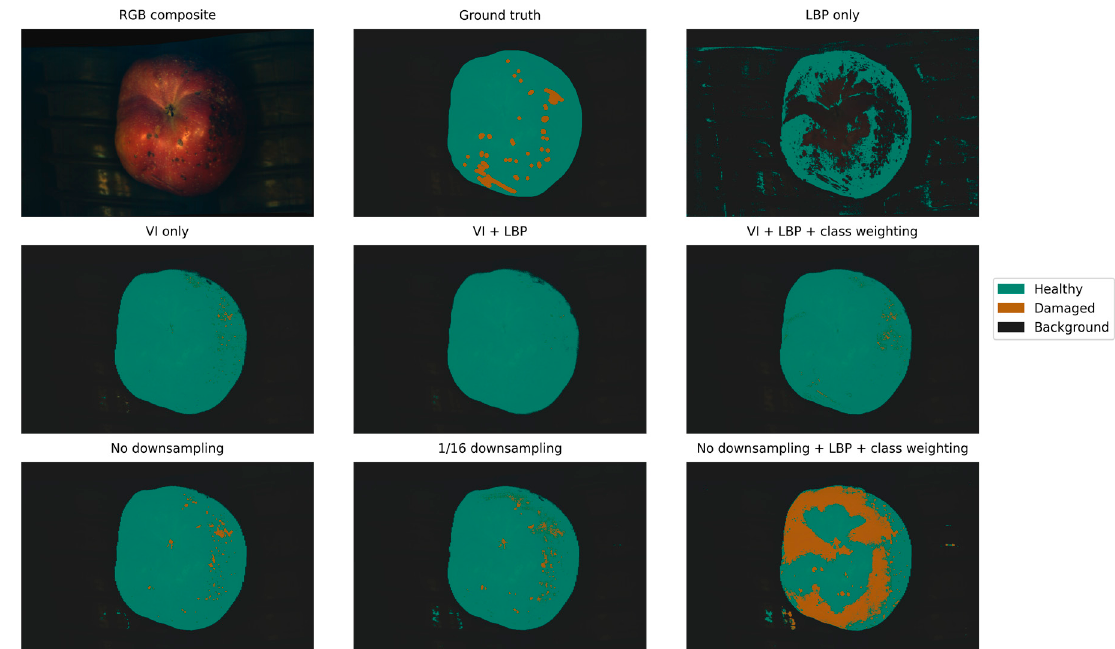
Figure 4. Classification results for a healthy apple.